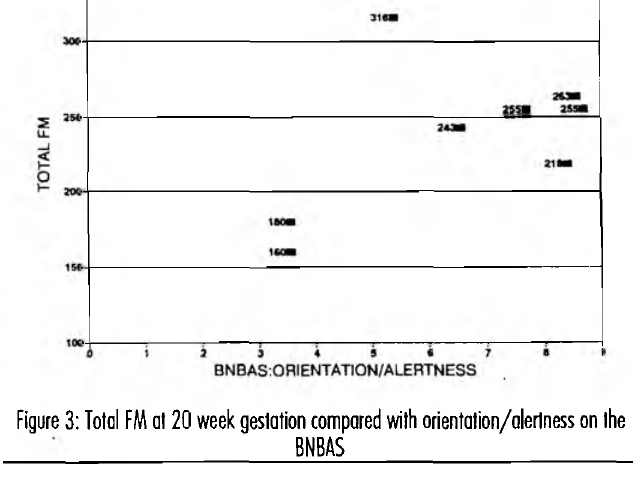
TABLE IV: BRAZELTCIN NEONATAL BEHAVIOURAL ASSESSMENT SCALE SCORES